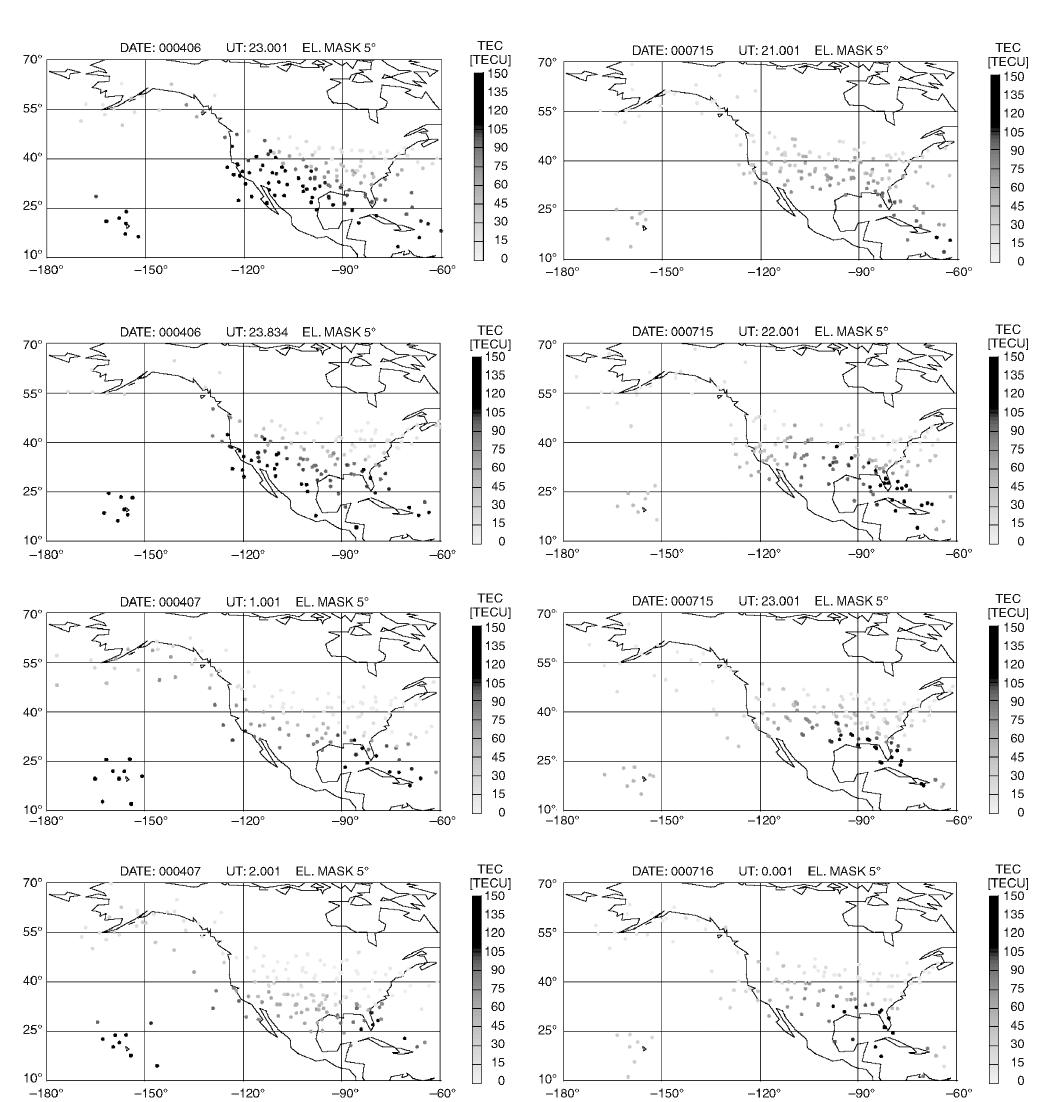
Fig. 18.3. Equivalent vTEC for April 06, 23:00, 23:50 UT; April 07, 01:00, 02:00 UT ( left panels) and equiv- alent vTEC for July 15 21:00, 22:00, 23:00 UT; July 16, 00:00 UT ( right panels).